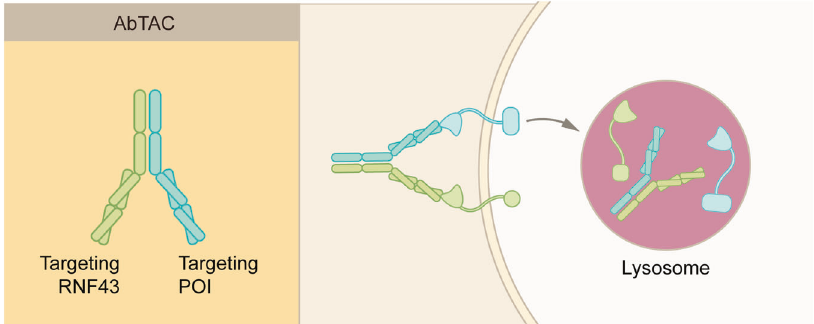
Fig. 8 Schematic representation of AbTAC. AbTAC utilizes recombinant bispeci fi c antibody to recruit a membrane protein and a membrane- bound E3 ligase, RNF43. The POI is likely degraded via the lysosomes, but not by the proteasomes. However, the exact mechanisms remain to be